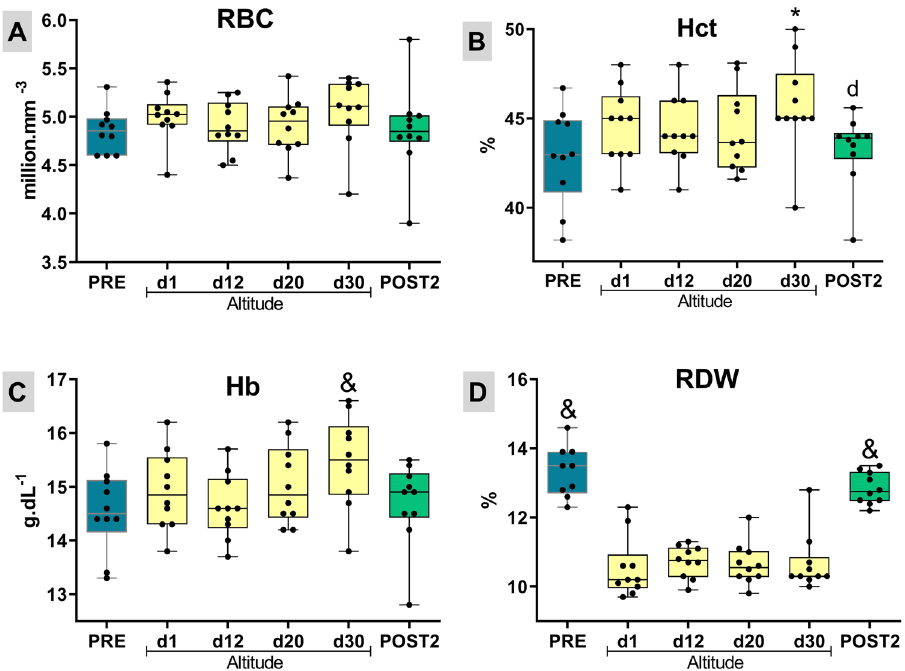
Figure 6. Red blood cells—RBC ( A ), hematocrit—Hct ( B ), Hemoglobin—Hb ( C ). ( D ) The red blood cell distribution width (RDW). Box plots depict median value (line in the box) with box edges representing 25th–75th percentiles and whiskers showing range of values (min to max). *Different of PRE; d different of d30; & different of all other groups (according to repeated ‐ measures ANOVA, using the Newman–Keuls post-hoc test).